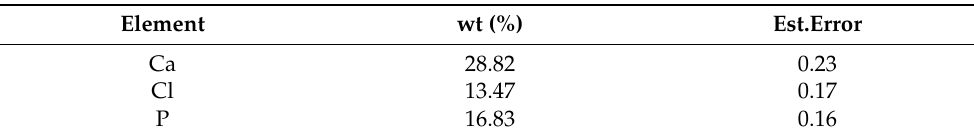
Table 2. Contents of the main elements in the chemical composition of the raw materials used in this study (by XRF method).